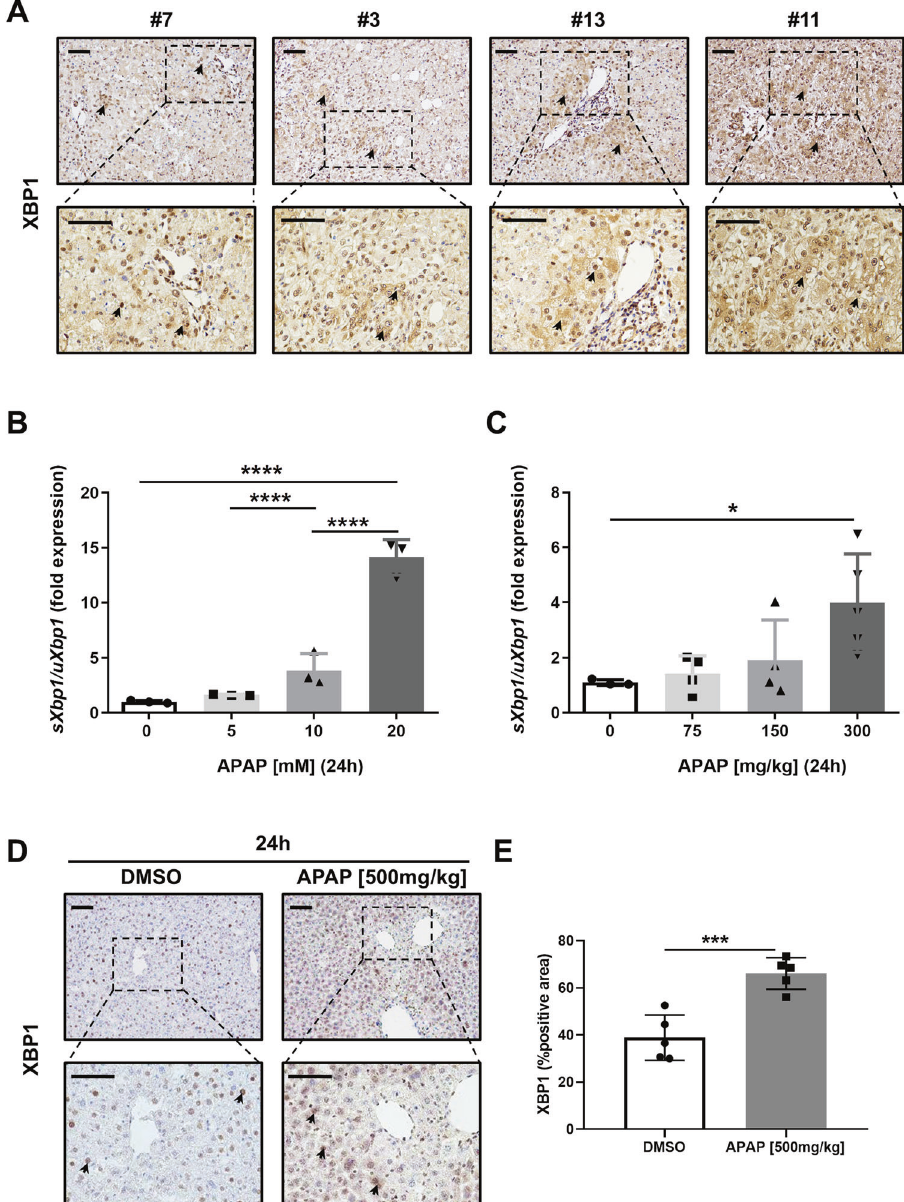
Fig. 1 The expression of XBP1 increases during APAP overdose both in mouse and human. A Representative XBP1 staining performed on paraf fi n liver sections of patients with acute liver failure (ALF) due to APAP overdose. Scale bars, 100 μ m (top) and 50 μ m (bottom) ( N = 13). B mRNA levels of sXBP1/uXBP1 in HepaRG cells, were determined by RT-qPCR, 24 h after APAP challenge. C mRNA level of sXBP1/uXBP1 in C57BL/6J wild-type (WT) mice was determined by RT-qPCR, 24 h after APAP injection. D Representative XBP1 staining was performed on paraf fi n liver sections of C57BL/6 wild-type (WT) mice, 24 h post-APAP [500 mg/kg]. Scale bars, 100 μ m and 50 μ m. E Quanti fi cation of XBP1- positive area was performed. Data are expressed as mean ± SEM and graphed, separately (* p < 0.05- **** p < 0.0001; N = 3 – 5 animals per experimental